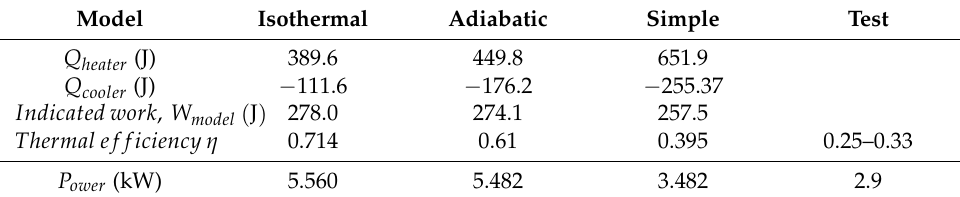
Table 2. Summary of